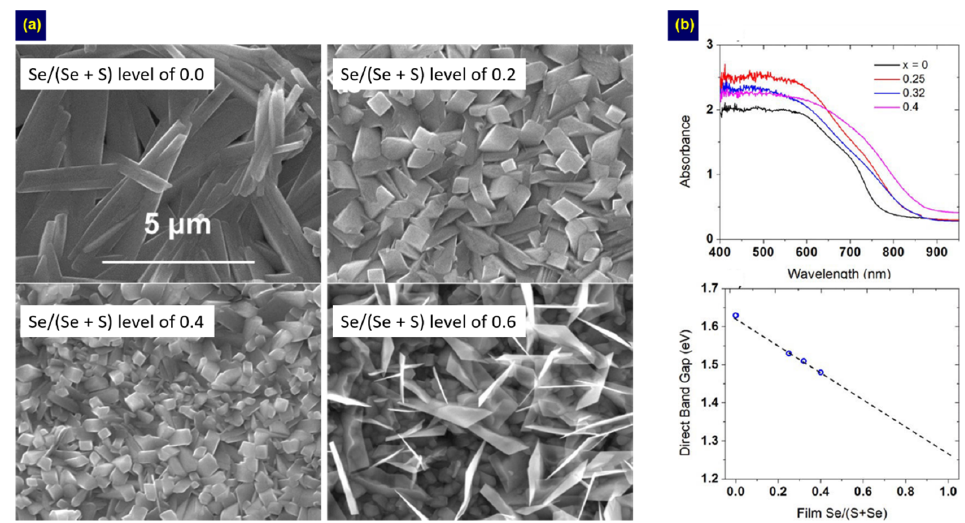
Figure 2. Images and plots characterizing Se-doped BiSI films fabricated by spray pyrolysis at varied Se doping levels including: ( a ) surface morphologies; ( b ) absorption and direct E g graph.